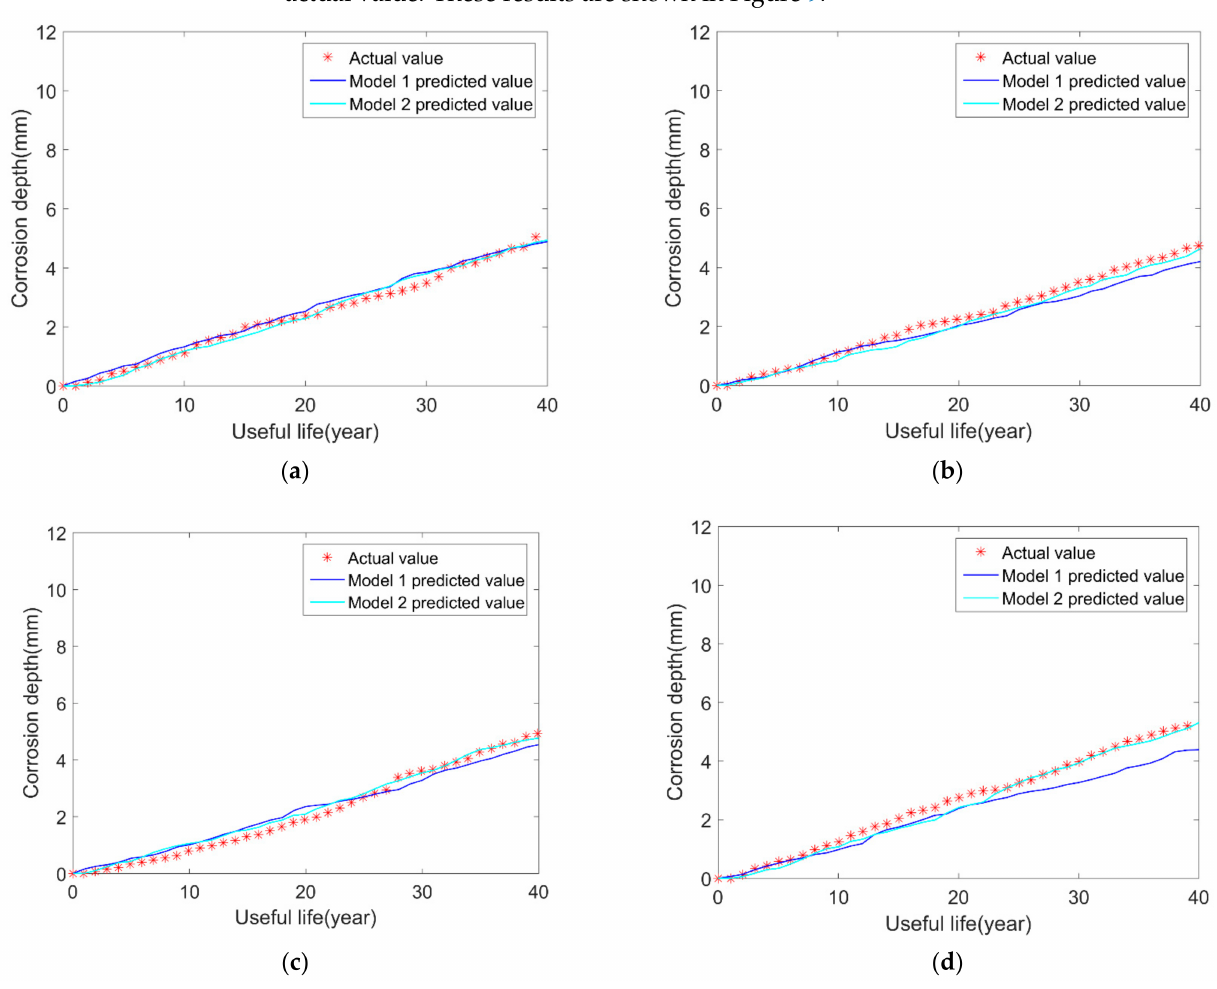
Figure 9. Comparison results of the two models and the real results: ( a ) sample 1; ( b ) sample 2; ( c ) sample 3; ( d ) sample